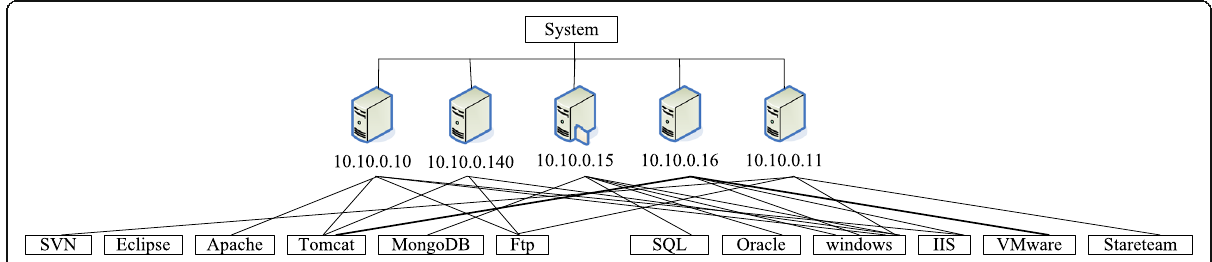
Fig. 4 Hierarchical structure partition diagram of experimental network